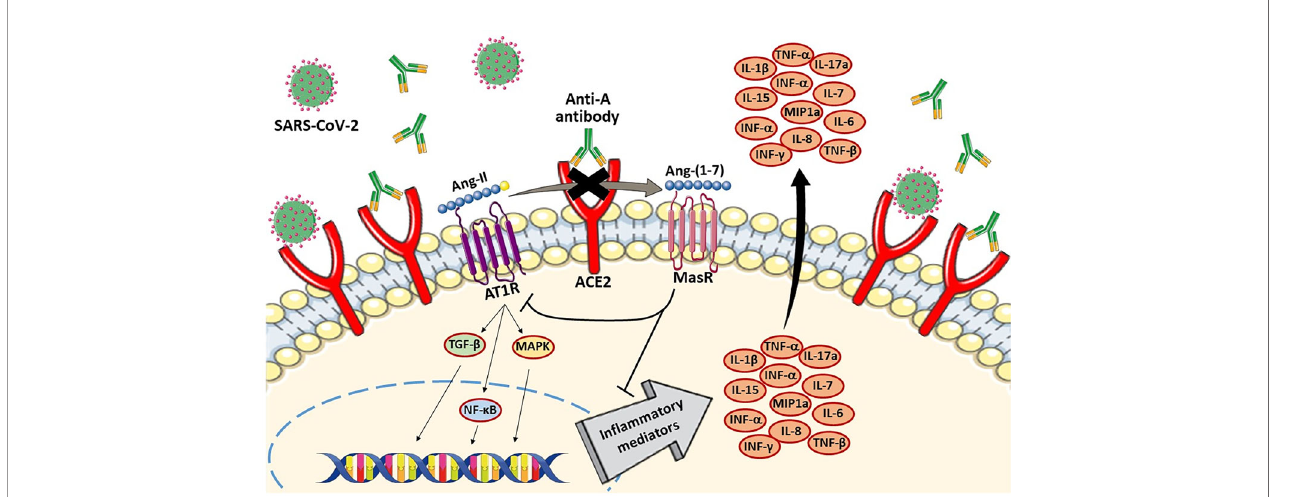
FIGURE 6 | Competitive inhibition of ACE2 by both anti-A antibodies and SARS-CoV-2 in blood group O patients. The SARS-CoV-2 and anti-A antibodies induced ACE2 downregulation. Ang-II can activate NF- k B pathway in AT1R-mediated in fl ammatory response, leading to the increased production of multiple in fl ammatory cytokines. Therefore, SARS-CoV2 had more dif fi culties to use ACE2 as the cellular entry receptor because of anti-A